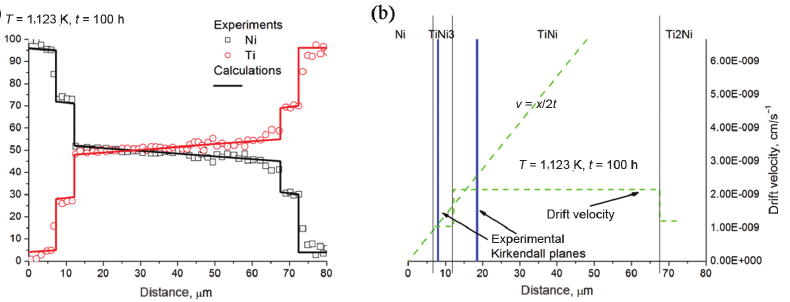
Figure 3: (a) The concentration profile after the diffusional annealing in Ni – Ti diffusion couple after 100 h at 1,123 K. Dots show the experimental results and lines are simulations; (b) vertical lines represent the experimentally determined position of Kirkendall planes, the dotted line denotes the calculated drift velocity.